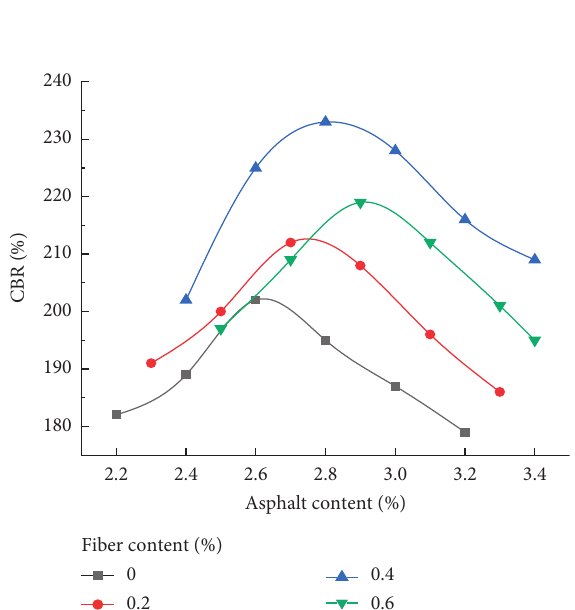
Figure 5: Relationship between CBR and fiber content.